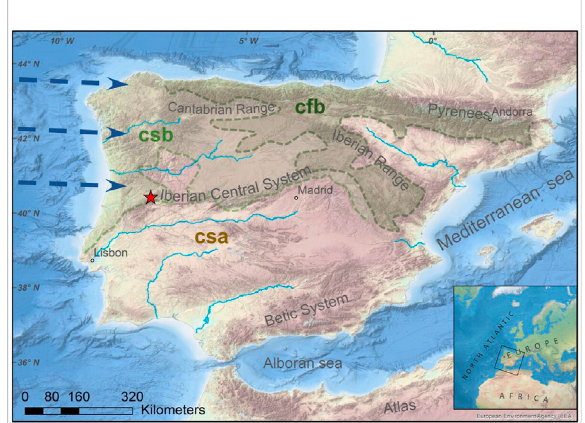
FIGURE 1 Morphological map of the Iberian Peninsula. The red star indicates the Lake Peixão location (Serra da Estrela, Portugal). Csa: Hot summer Mediterranean climate; Csb: Mild summer Mediterranean climate; Cfb: Oceanic. The dark blue arrows represent the moist rich prevailing westerlies from the Atlantic Ocean entering Iberia. Sources: European map from shadedrelief. com.RivernetworkfromtheEuropeanEnvironmentAgency(EEA). Topography and bathymetry, sourced from portal.emodnet- bathymetry.eu, overlapped with the simpli fi ed Köppen-Geiger climate classi fi cation for the Iberian Peninsula (1971 – 2000) (adapted from the Iberian Climate Atlas,